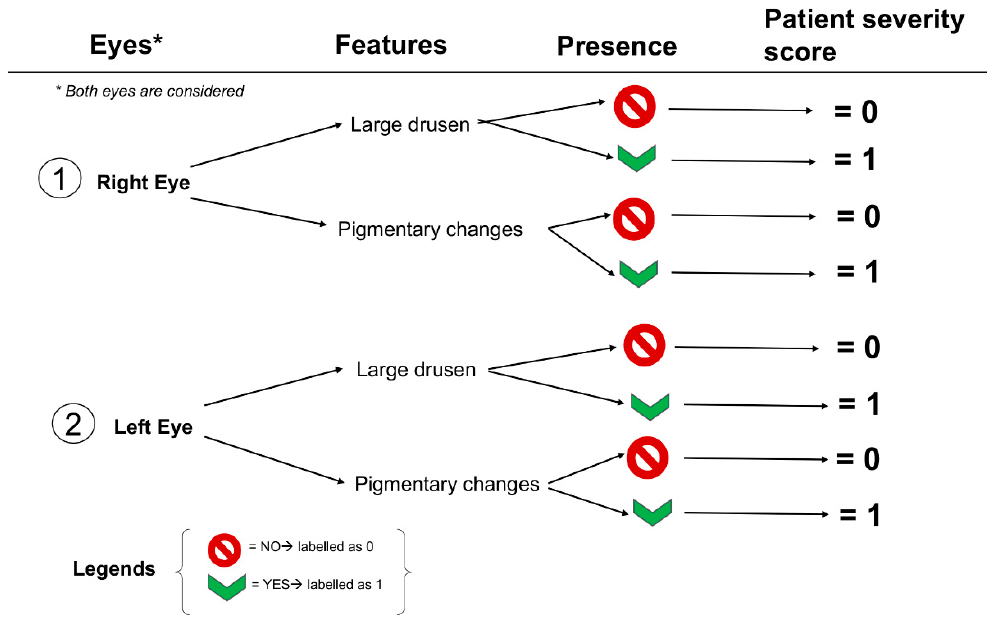
Figure 1. A schematization of the 4-steps simplified severity scale from AREDS report No. 18.